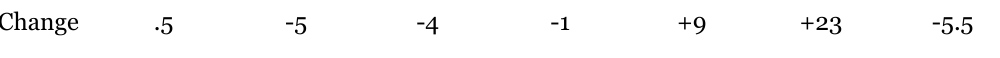
Change in CRT Scores for Teachers Using Open Textbooks Comparing 2009–2010 Aver- age Scores with 2011